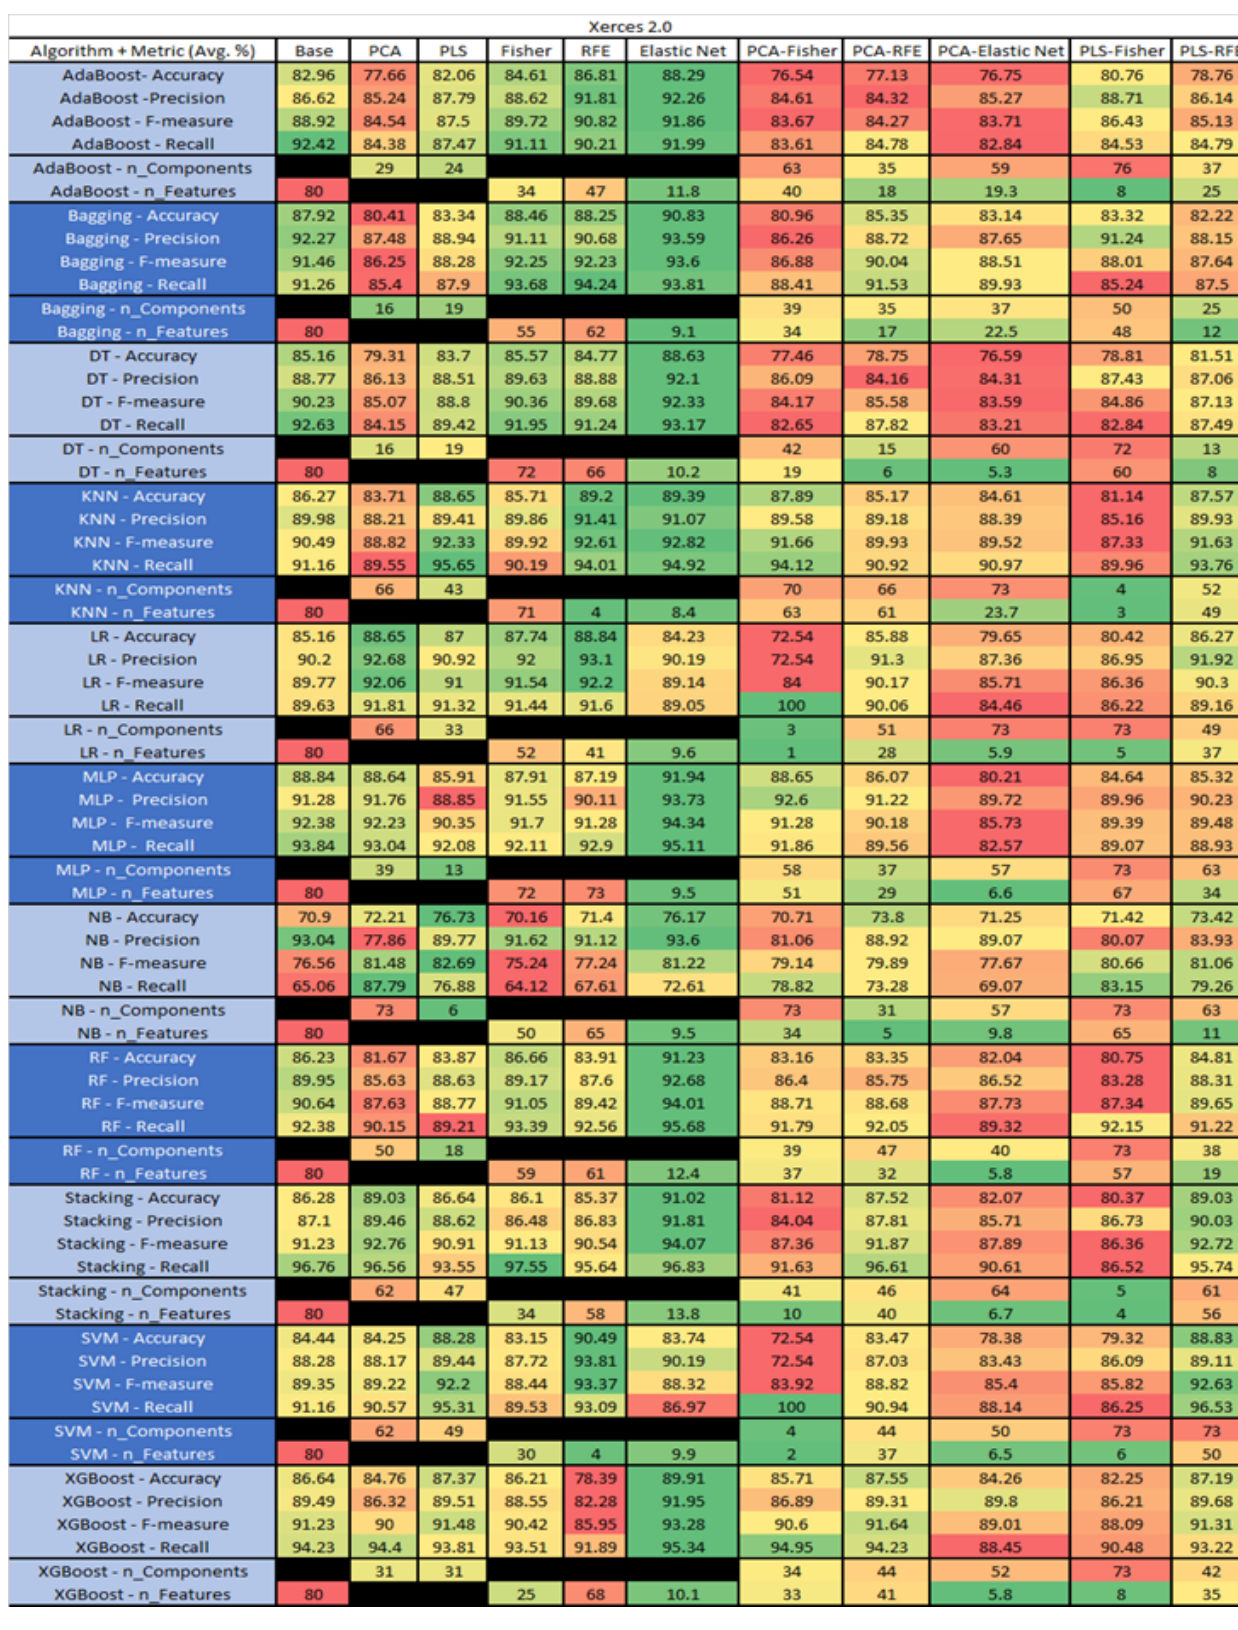
Figure 58. Xerces 2.0 PROMISE Results Data